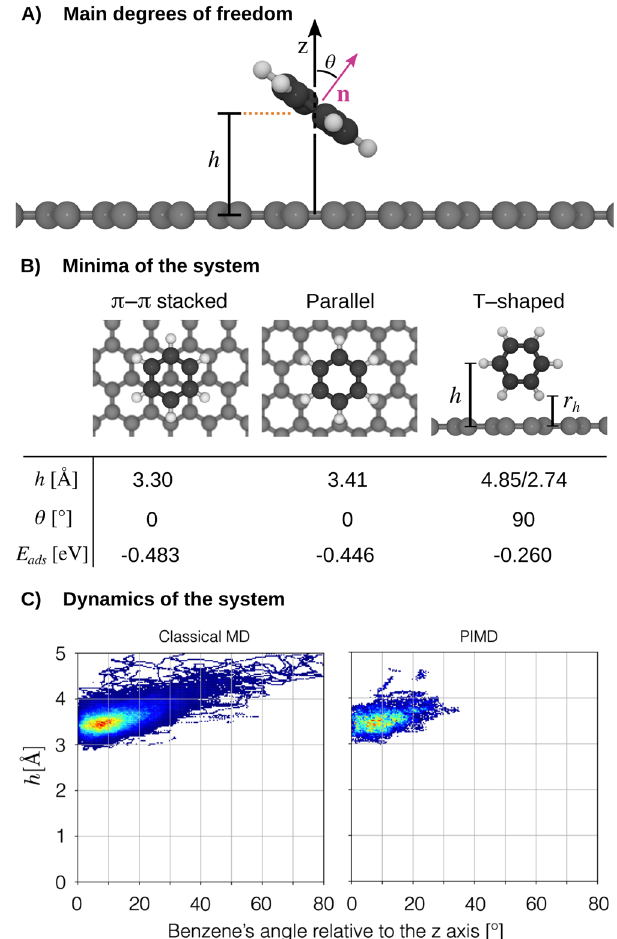
Fig. 8 Dynamical strengthening of non-covalent interactions. Benzene/ graphene. A Depiction of the system with its two main degrees of freedom: (1) The angle between the normal vector de fi ned by the benzene ring ^ n and the normal to the graphene plane ( ^ z ). (2) The relative distance between the benzene center of mass and the graphene, h . B The three minima of the systems and its de fi ning characteristic parameters: h , θ , and its adsorption energy in E ads . The E ads energies were computed using E ads = E benzene/ − ( E + E benzene graphene ). C Classical molecular dynamics (MD) and graphene path integral molecular dynamics (PIMD) simulations describing the dynamics of benzene molecule interacting with graphene at room temperature described by the BIGDML molecular force fi eld. Plots displaying projections of the dynamics (classical MD and PIMD) to the two main degrees of freedom of the system: h , θ = arccos( ^ z (cid:6) ^ n ). ð 3 Þ (cid:3) O , and described at the DFT-PBE level of group T 2 ´ 2 ´ 2 h